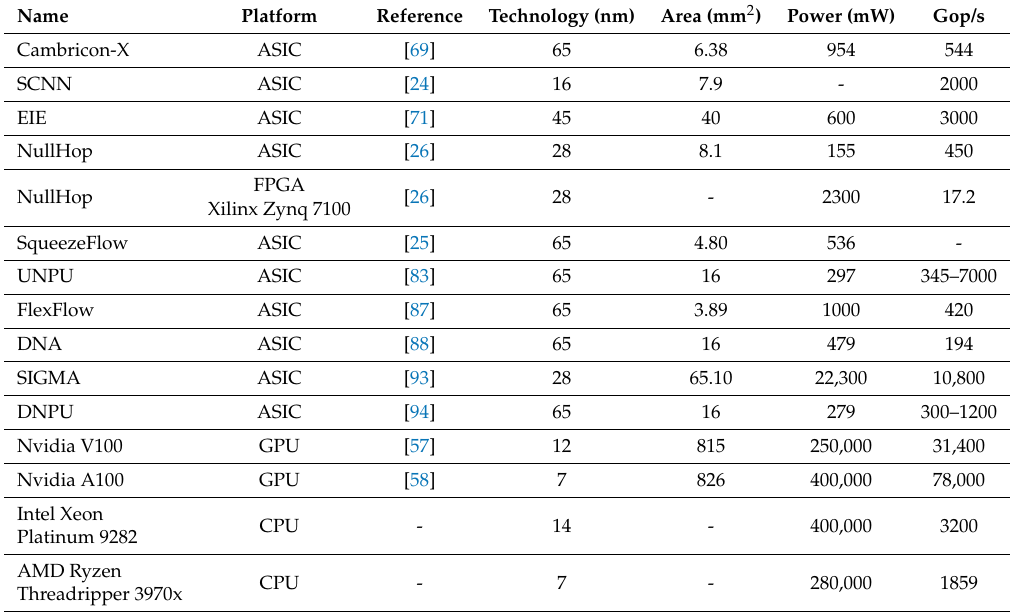
Table 4. Comparison between accelerations implemented on different hardware